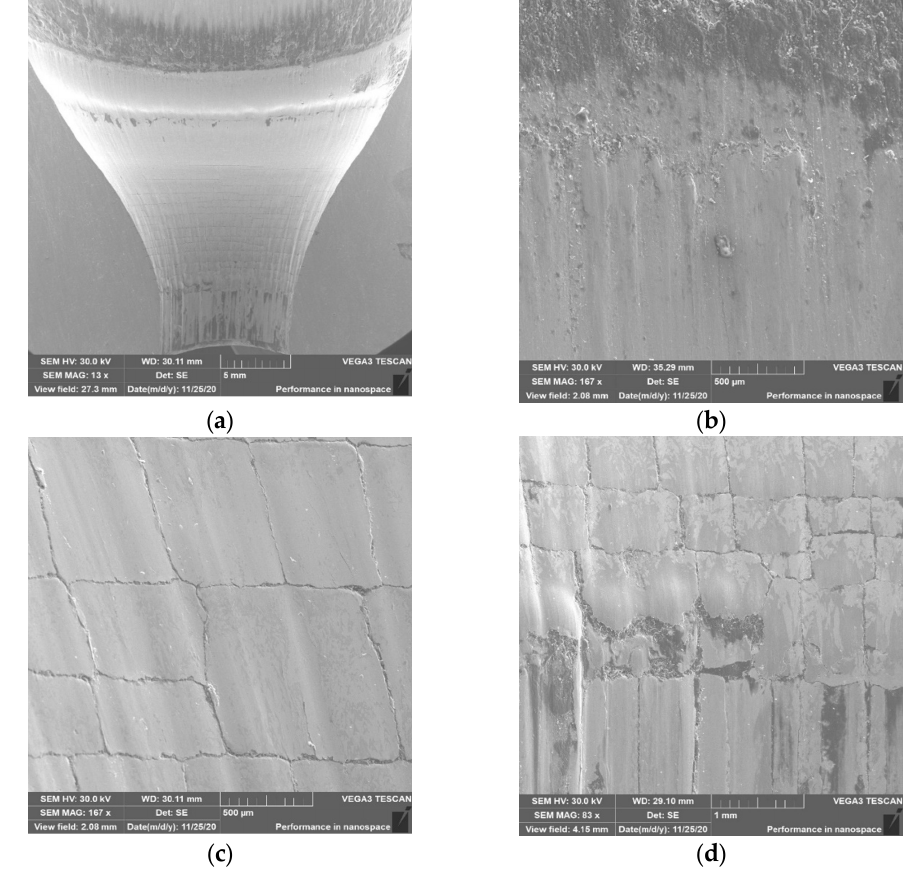
Figure 15. SEM analysis for tool 3: ( a ) cavity; ( b ) area in zone 1; ( c ) area in zone 2; ( d ) area in zone 3.